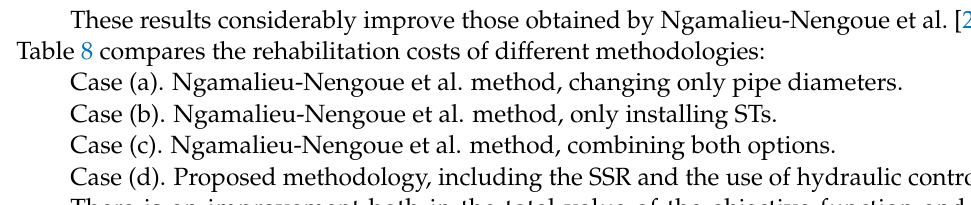
Figure 9. Infrastructure to be implemented in the network after final